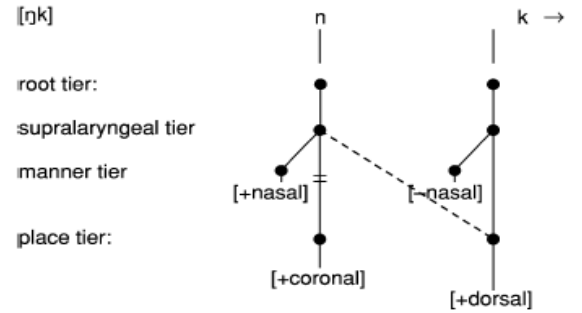
Figure 2. Assimilation in feature geometry (Mielke and Hume 2006, p. 727).